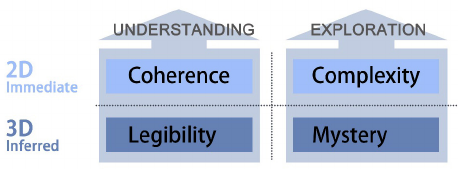
Figure 1. The preference matrix developed by Kaplan et al.